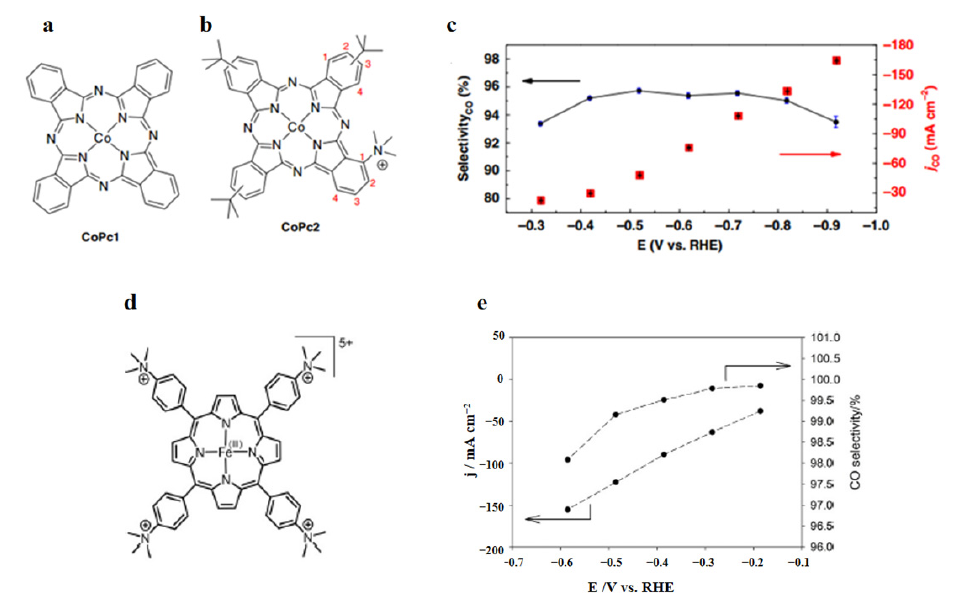
Figure 6. Structure of: ( a ) cobalt phthalocyanine catalyst CoPc1; ( b ) CoPc2. ( c ) FE CO and j CO of CoPc2 vs. potential. Reproduced with permission from Ref. [116]. Copyright 2019 Springer Nature Limited. ( d ) Structure of FeP; ( e ) j CO and FE CO of FeP vs. potential. Reproduced with